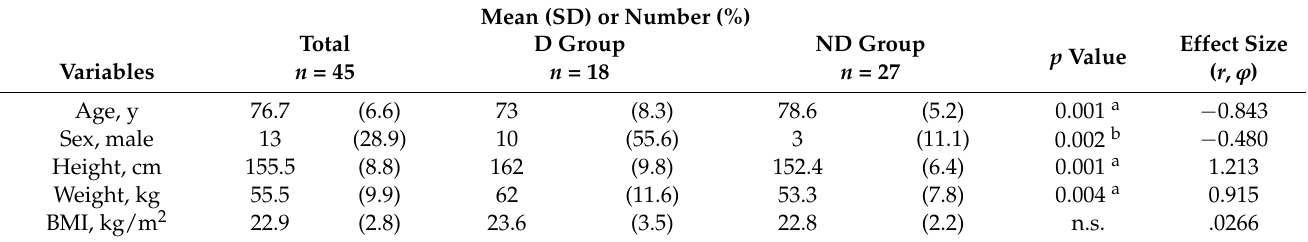
Table 1. Characteristics of subjects.